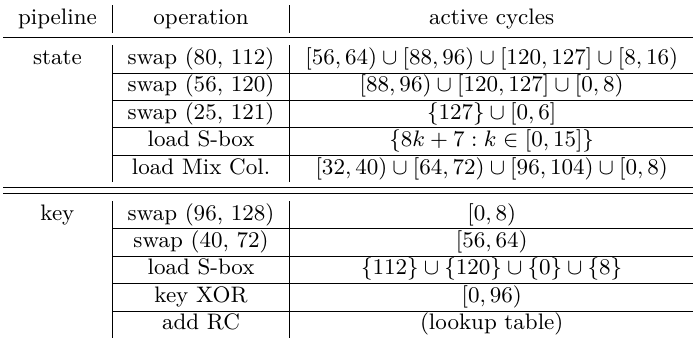
Table 5: The timetable of operations for bit-serial AES